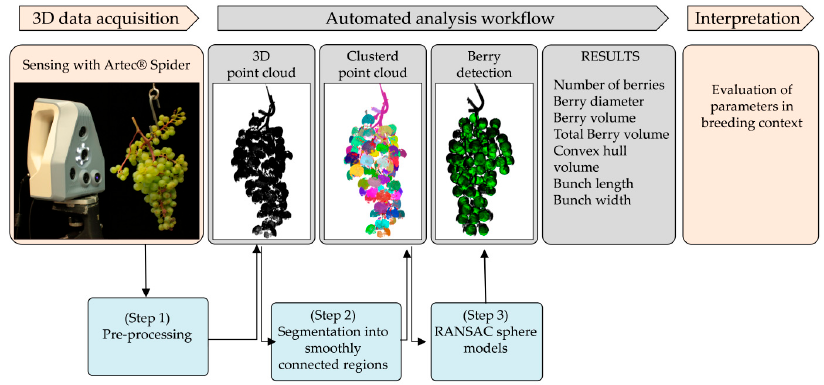
Figure 2. Phenotyping pipeline: data acquisition and data analysis to phenotype 3D bunch traits. Bunches were fixed on a motorized hook and scanned 360° (or from the front) resulting in a dense point cloud of the bunch. Data analysis was conducted with 3D-Bunch-Tool (3D-BT). In a first step, the point cloud is segmented and characterized in its visible parameters. The output data are number of berries, berry diameter, berry volume, bunch length, bunch width and convex hull volume.